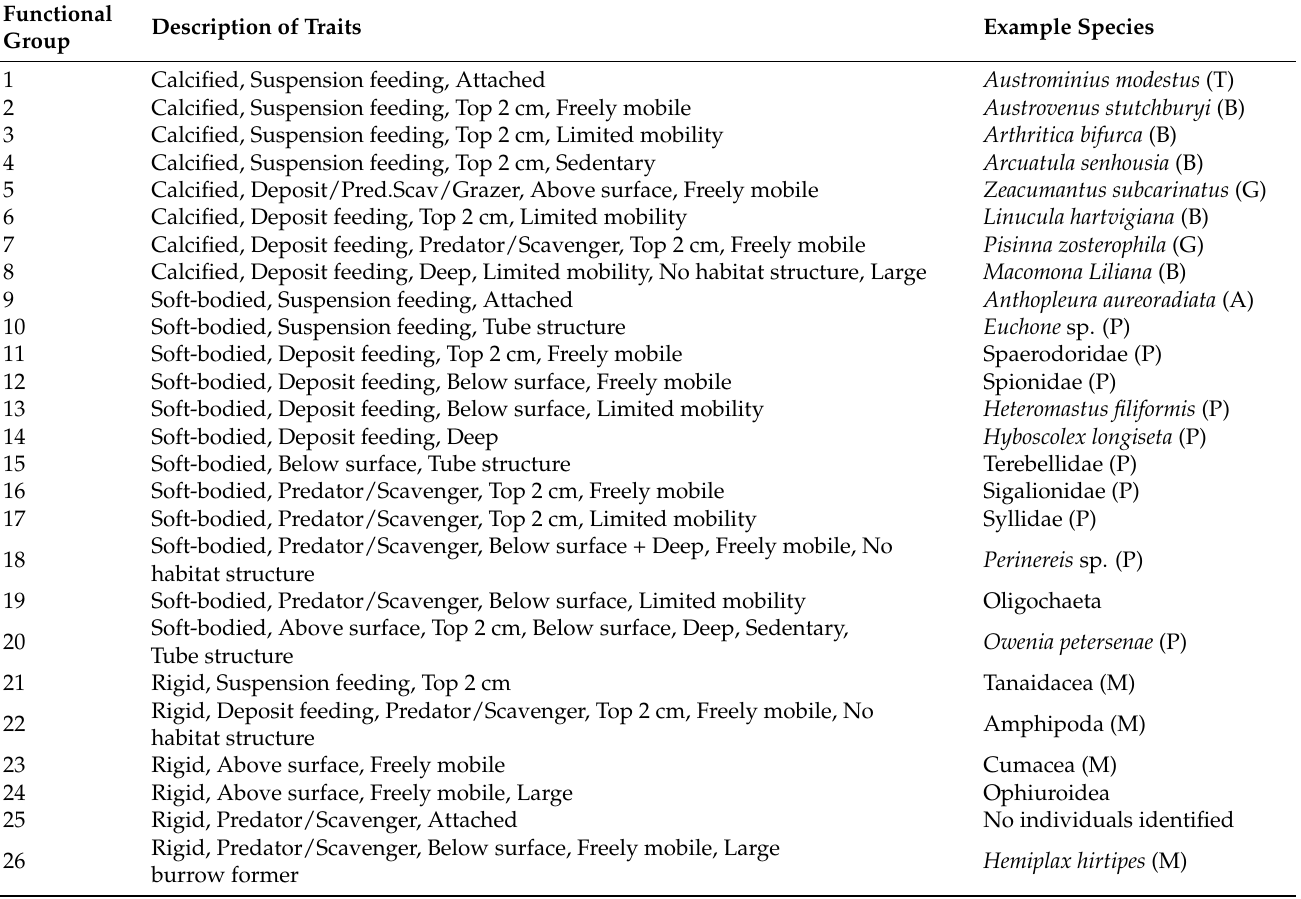
Table 1. Summary of defining traits for each functional group (1–26) as described by Greenfield et al. [59]. An example species are given for each group. Taxonomic class indicated within brackets; T = Thecostraca, B = Bivalvia, G = Gastropoda, A = Anthozoa, P = Polychaeta, M =